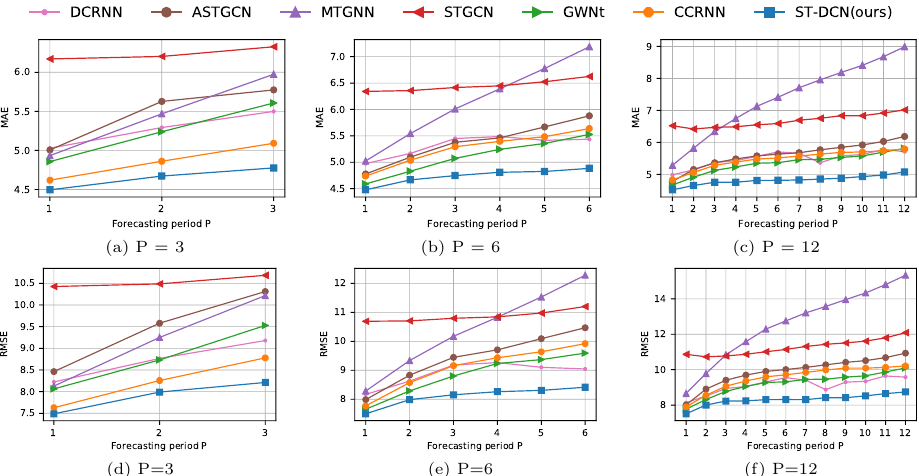
Figure 7. Comparison of the performance of different methods as the forecasting time increases on the NYC taxi